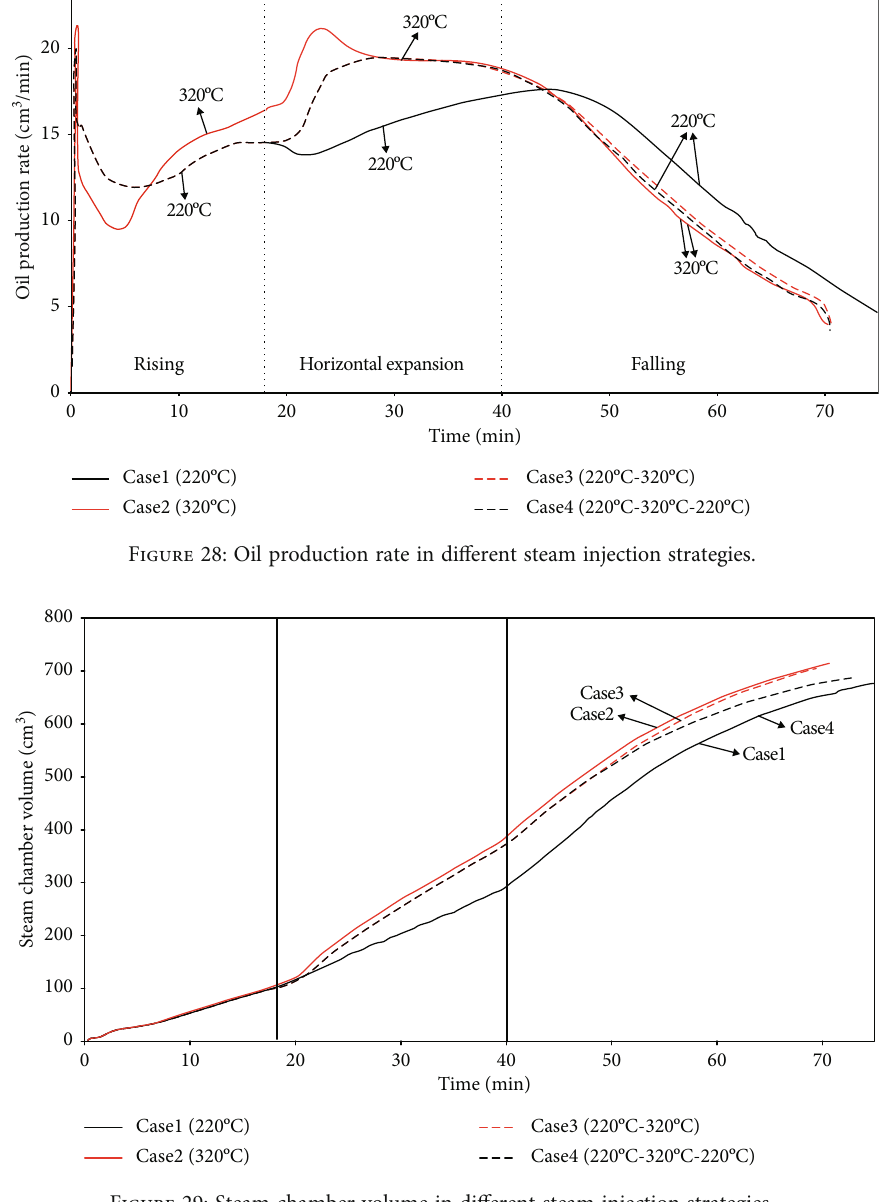
Figure 29: Steam chamber volume in di ff erent steam injection strategies.